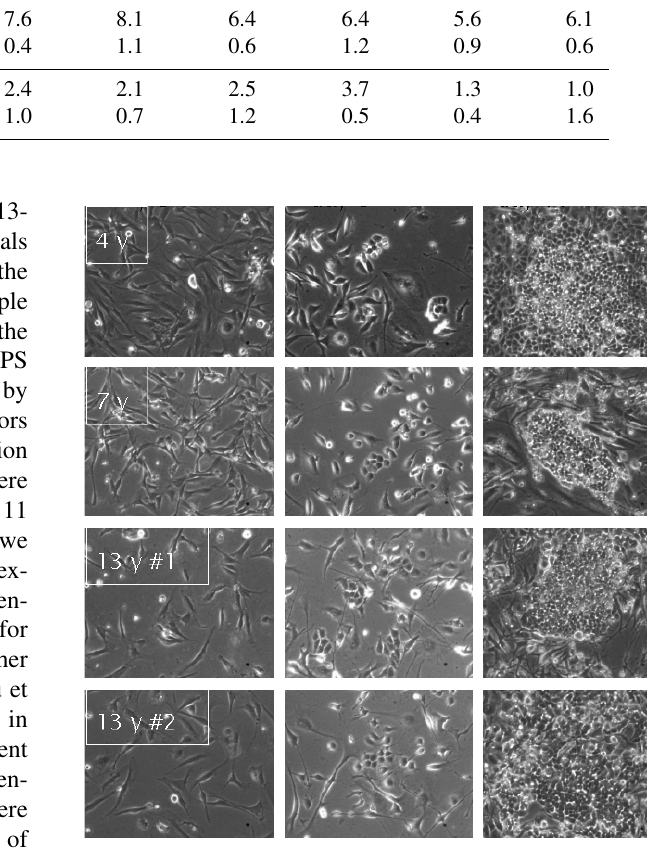
Figure 2. Development of iPS colonies generated from a 4-year- old, a 7-year-old and two 13-year-old marmosets. Columns from left to right show colony development at 0 days, 8 days and 11 days after the second retroviral infection. Generated iPS cells quickly displace surrounding fibroblasts as tight colonies develop. The char- acteristic morphology of the newly formed colonies is a good indi- cator of